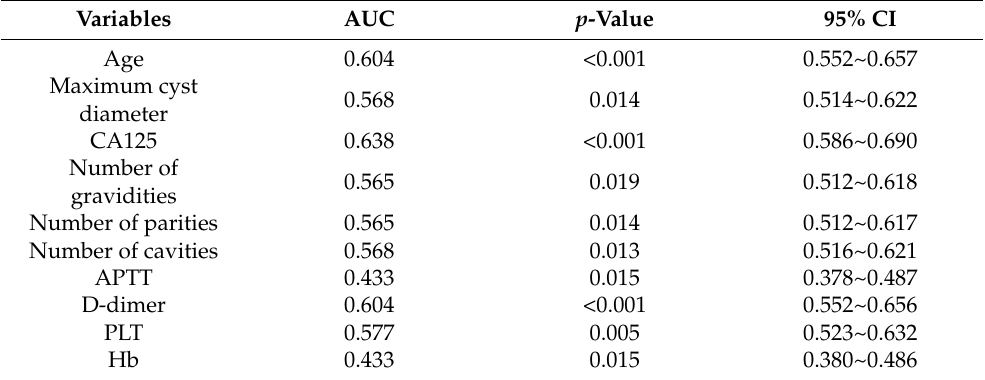
Table 4. ROC analysis of continuous variables with statistical differences between groups A and